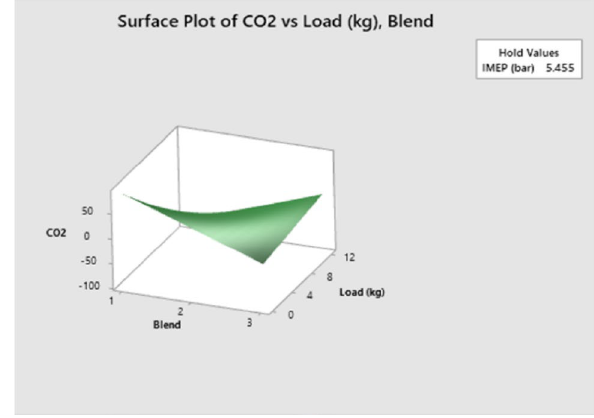
Fig. 26 Contour plot of CO with nanoparticles